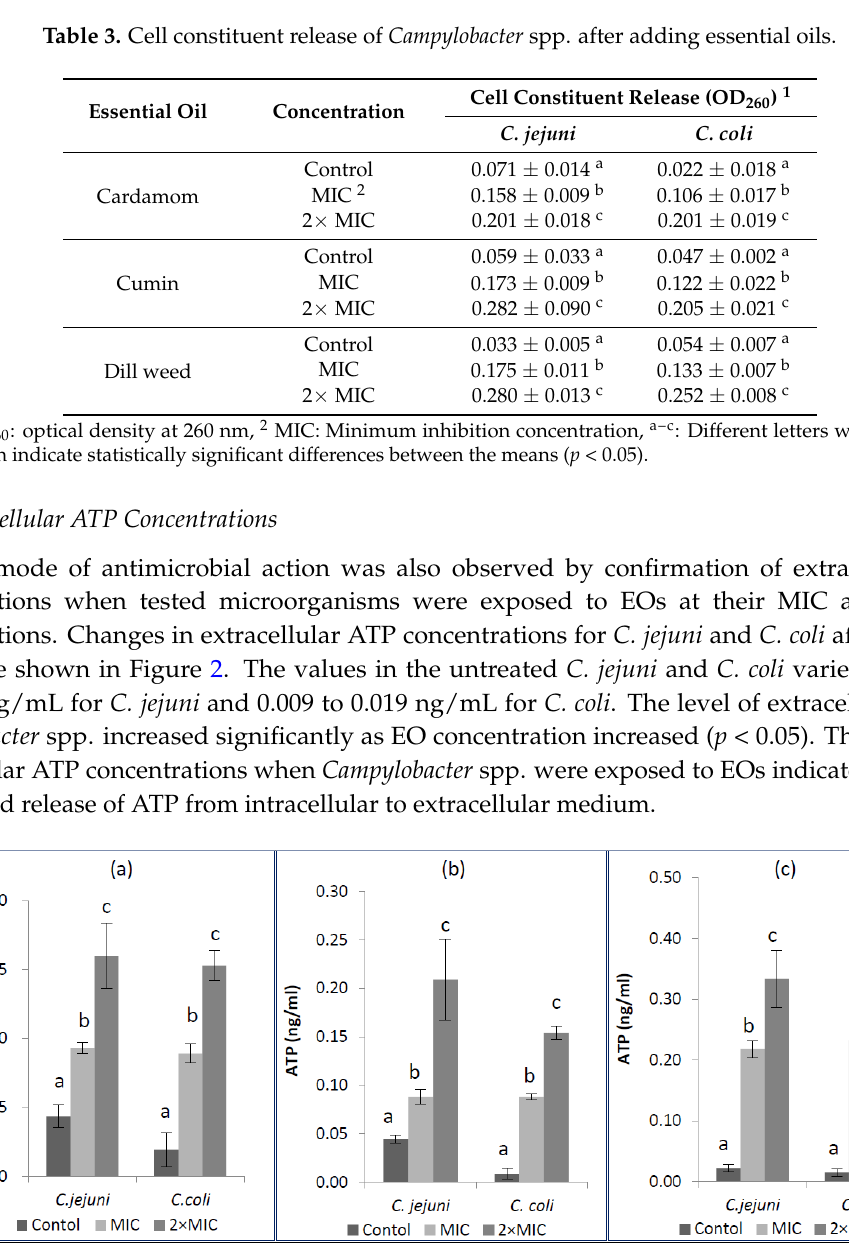
Figure 2. Extracellular ATP concentrations of Campylobacter spp. after adding cardamom ( a ), cumin ( b ), and dill weed ( c ) essential oils, MIC: Minimum inhibition concentration.